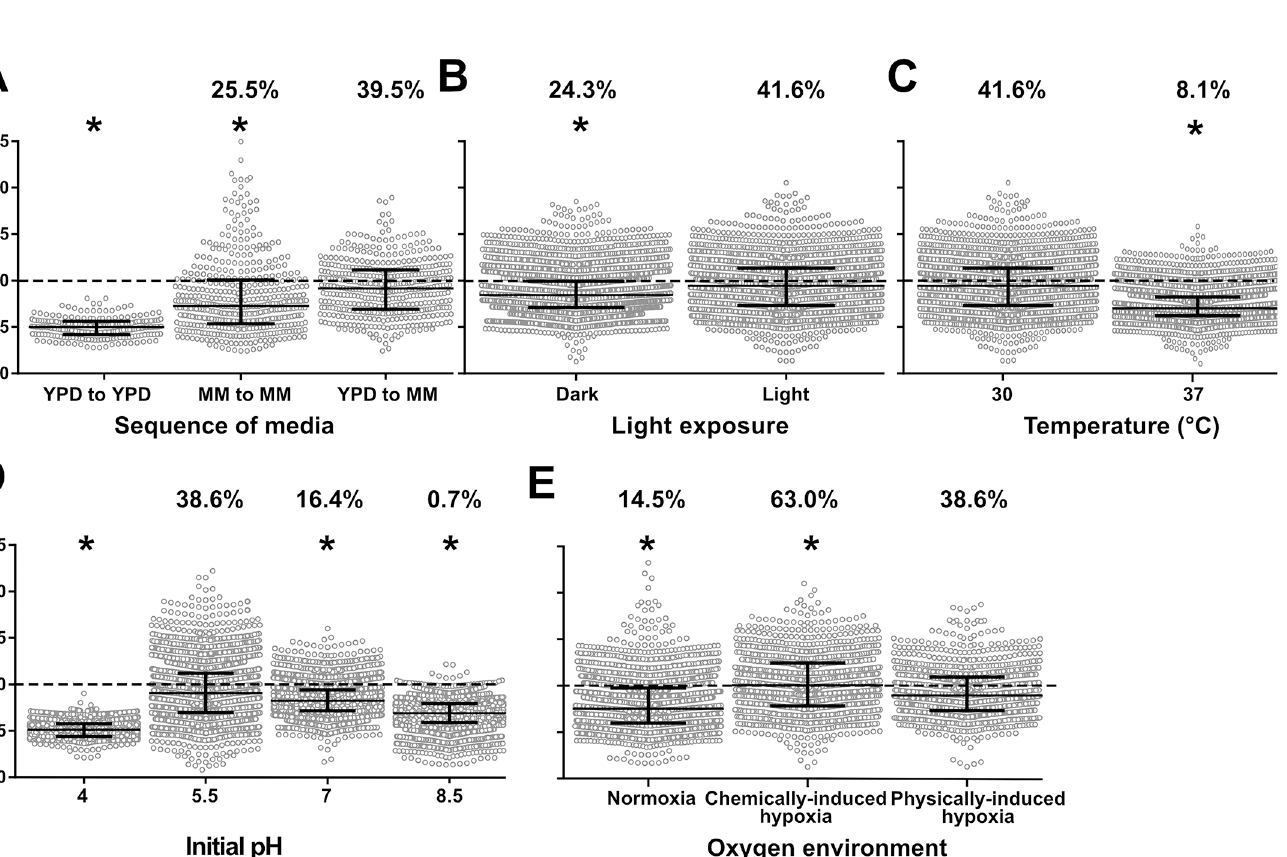
Fig 3. Dynamics of titan cells generation in vitro . ( A ) Cell body size was measured from samples of H99O culture (step 3 of the protocol) withdrawn at specific times (H0 to H120) using pictures taken in bright field and measured with the ICY software (mean number of yeasts counted ± SD = 219 ± 67, representative of three experiments). Cell size increased starting at H8 with some cells reaching the threshold of 10 μm (grey dashed line). Each dot represents a single cell and the bars represent median and IQR; ( B ) Titan cells generation started between H8 and H12 and reached a plateau at H24. Each dot represents the proportion of titan cells in the corresponding sample (3 independent experiments); ( C ) Pictures (x400 magnification) taken overtime showing the progressive increase in cell body size and the appearance of a vacuole typical of titan cells in a large cell at H8 (white arrow) (scale bar 10 μm); ( D ) Time lapse imaging of titan cells generation over 12 h showing that titan cells swelled progressively from a small cell and produced daughter cells after having increased their size. ( E ) Cells stained with calcofluor (CFW) at 0.1 μg/mL prior to incubation using our protocol. CFW fluorescent intensity is analyzed by flow cytometry in the initial (H0) and the resulting FSC/SSC high (titan cells) and FSC/SSC low (typical cells) observed at H24. The initial (H0) (green line) and the H24 FSC/SSC high (blue line) populations harbored a high CFW fluorescence suggesting that they are mother cells, with a higher fluorescence for the FSC/SSC high , while two populations of high and low (black star) CFW fluorescence intensity were observed for the H24 FSC/SSC low cells (Left panel). The right panel shows the size (FSC) and CFW fluorescence intensity of the yeast populations at H0 (black content lines) and H24 (yellow content lines). The initial population (CFW high /FSC low ) evolved in two populations, one corresponding to daughter cells (typical cells, CFW low /FSC low , white arrow), and the other one corresponding to titan cells (CFW high /FSC high , black arrow).